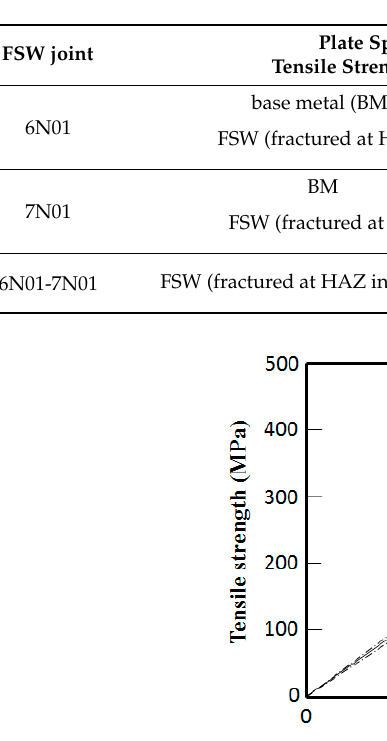
Table 2. Tensile strength of the friction stir welding (FSW) joints.